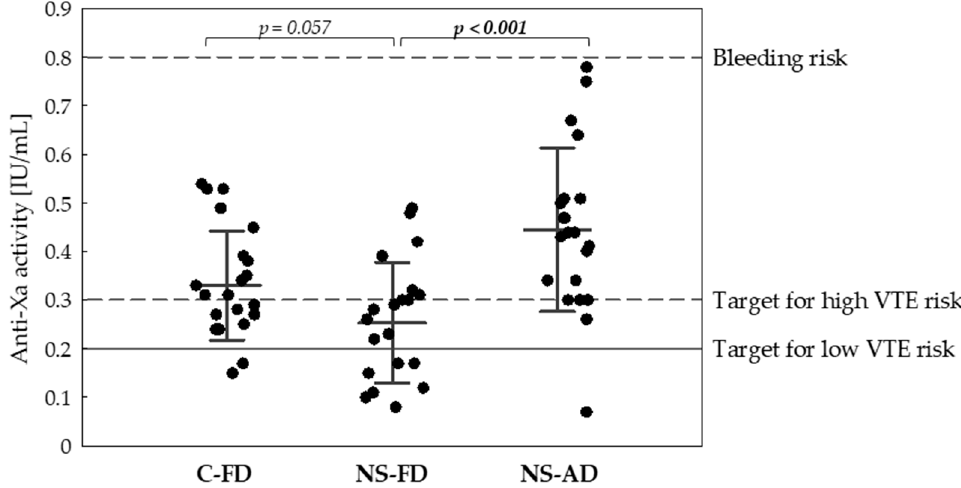
Figure 2. Anti-Xa activity of enoxaparin in the groups. p -values of one-tailed Fisher’s exact tests were presented.